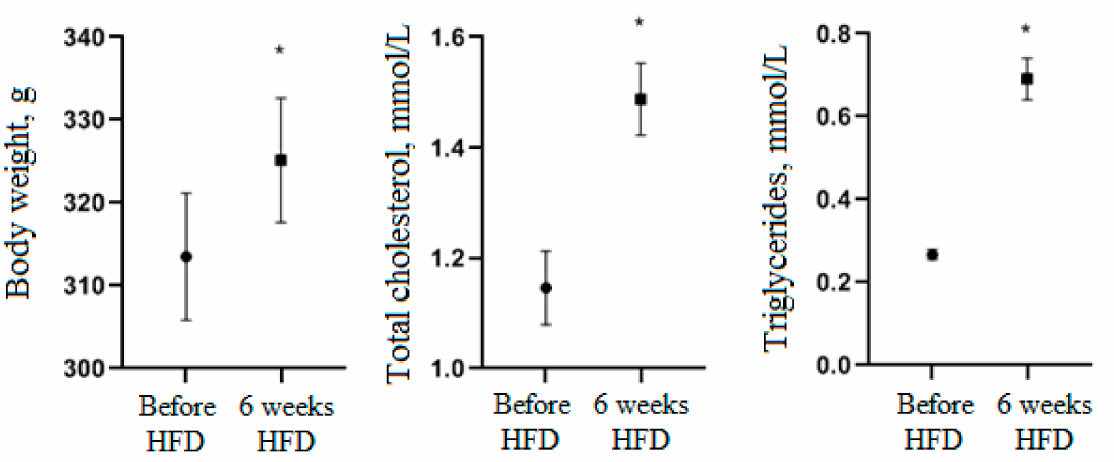
Figure 4. Changes in body weight of animals, total cholesterol and triglycerides in blood serum during the HFD period. * Significantly different from the period before HFD.